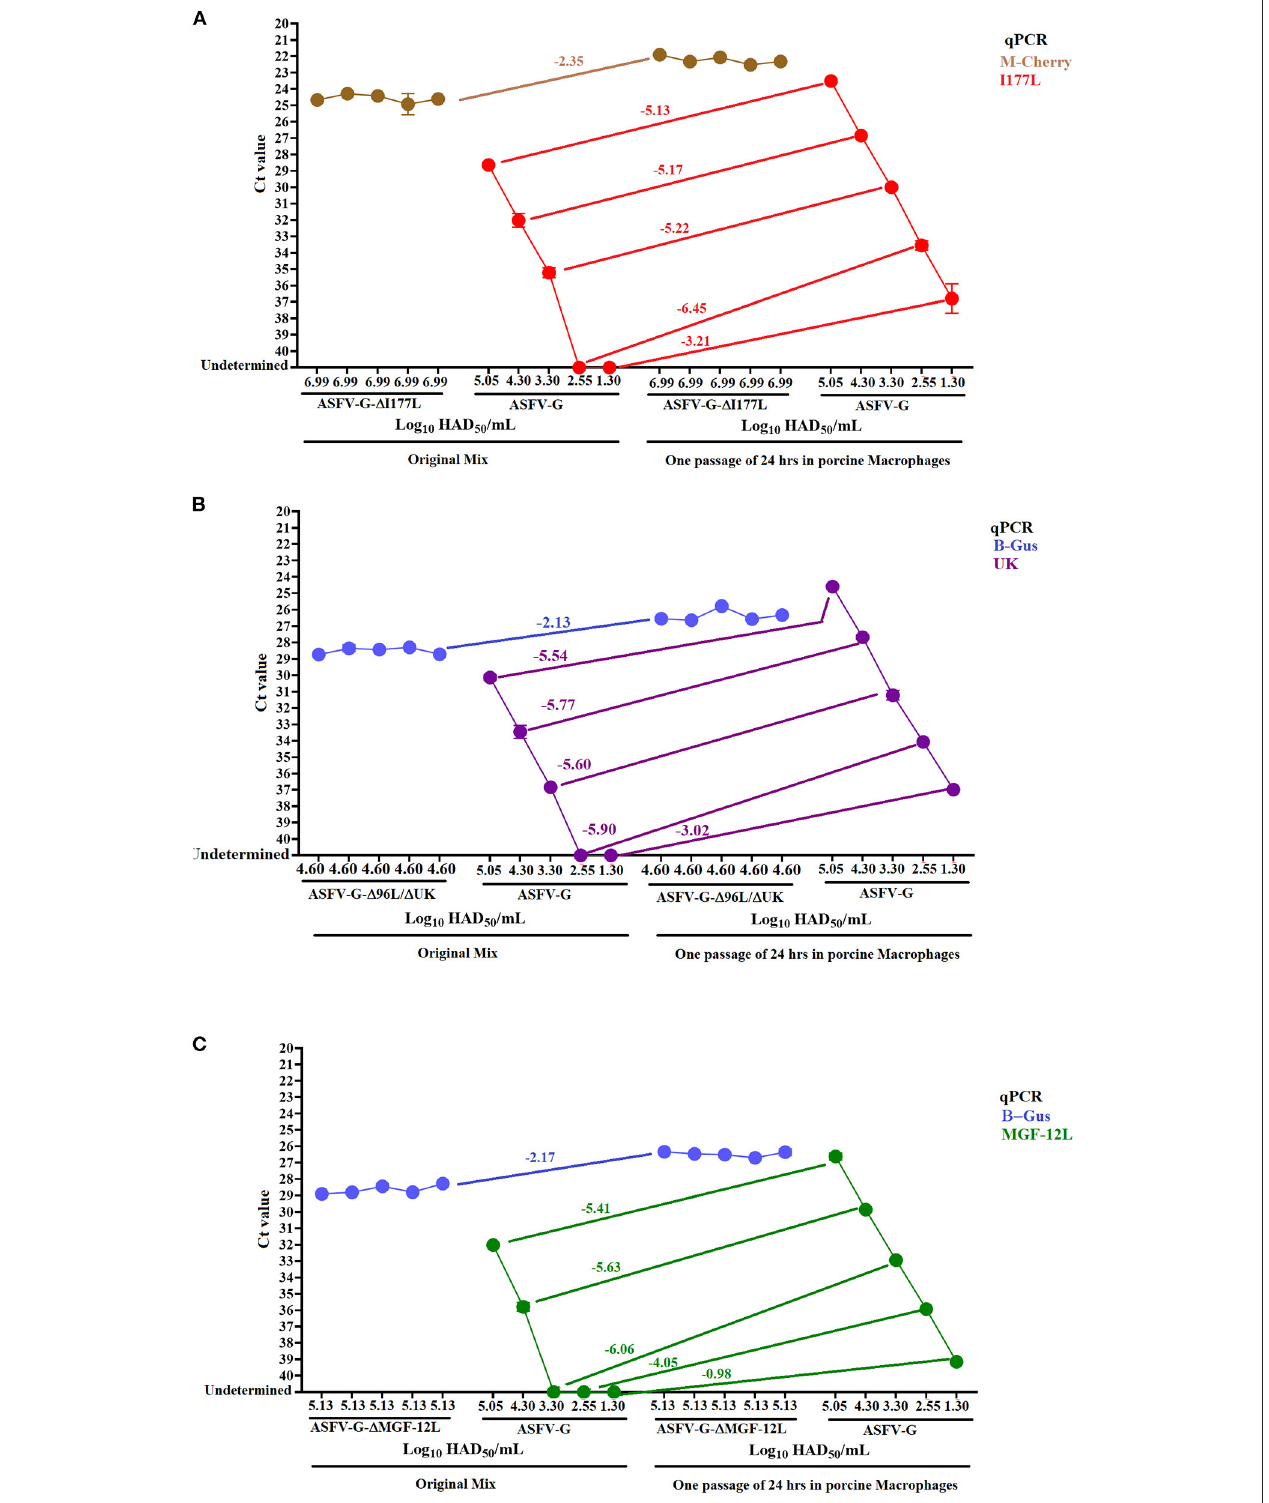
FIGURE 4 | Detection of ASFV-G in the presence of recombinant viruses. The sensitivity of different real-time PCRs was evaluated using mixes obtained from combined infections using constant concentrations of recombinant viruses and variable amount of ASFV-G (A) ASFV- 1 I177L, (B) ASFV-G- 1 9GL/ 1 UK, and (C) ASFV- 1 MGF. This evaluation was carried out in both the original virus mixes and after being passed once in porcine macrophage. The detection of recombinant viruses was conducted using specific qPCRs to detect the gene encoding the markers M-cherry (ASFV- 1 I177L) and β -Gus (ASFV-G- 1 9GL/ 1 UK and ASFV- 1 MGF).